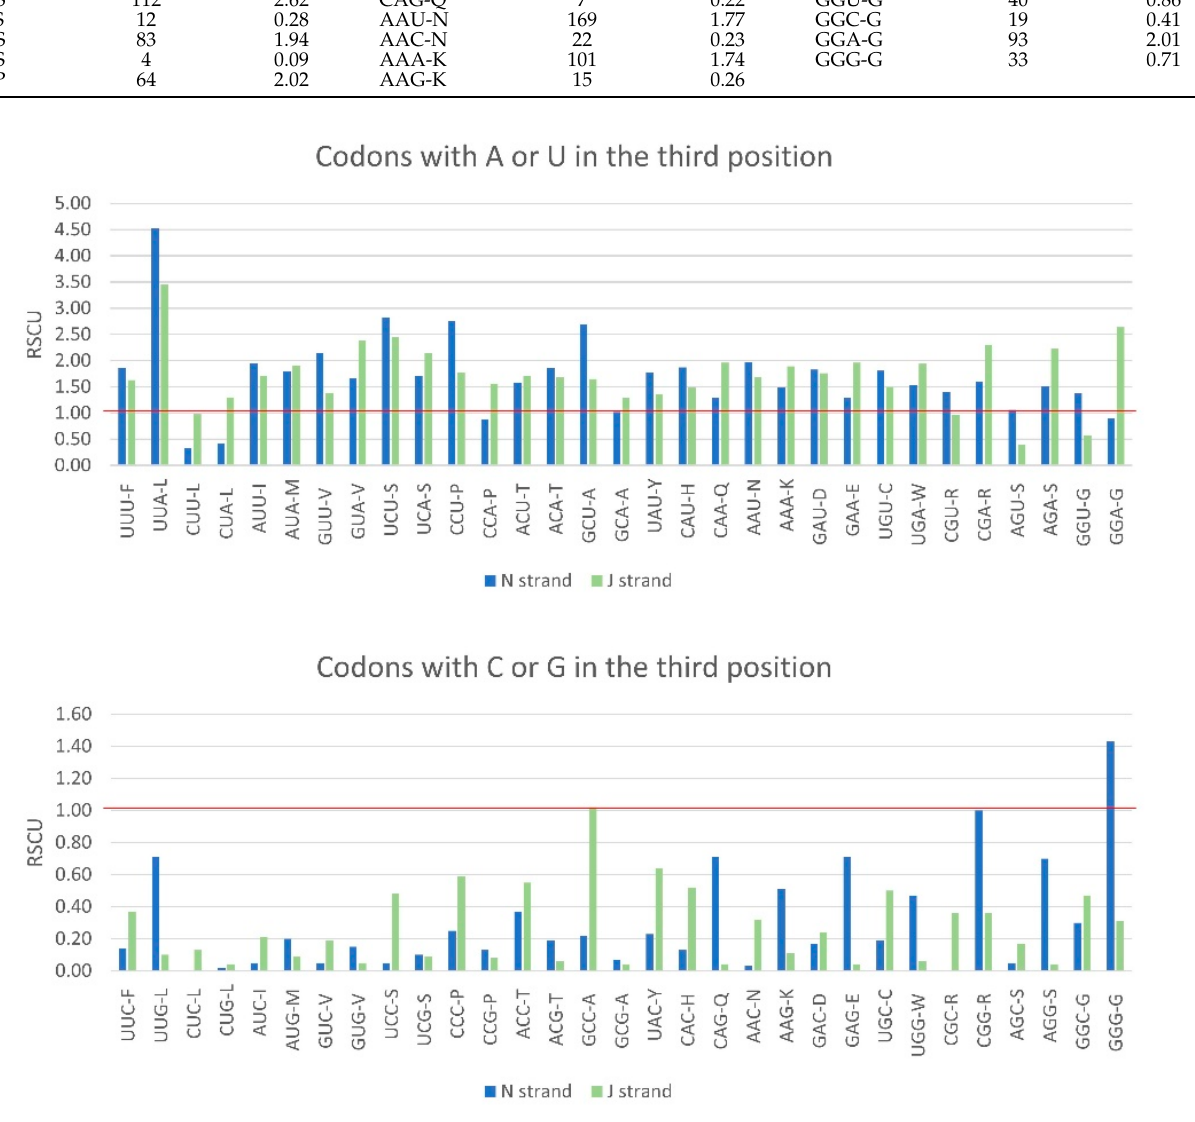
Figure 4. Codon usage and relative synonymous codon usage (RSCU) in the mitogenome of Anchonocranus oleae .